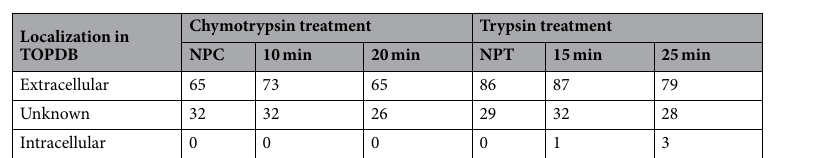
Table 3. The identified labelled sites were validated with other experimental topology data for the respective TMPs from TOPDB. Header: protease for pre-digestion, first column: location of experimental data in the TOPDB. Extracellular: identified as extracellular in other experiments, Intracellular: not extracellular position in other experiments, Unknown: no data